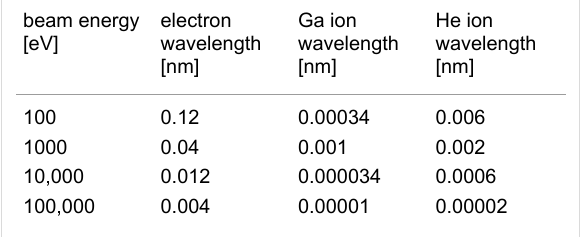
with the earlier Ga + systems, and reduced proximity effect, are the reasons for the renewed interest in ion beam lithography in the form of scanning helium ion beam lithography or “SHIBL”.